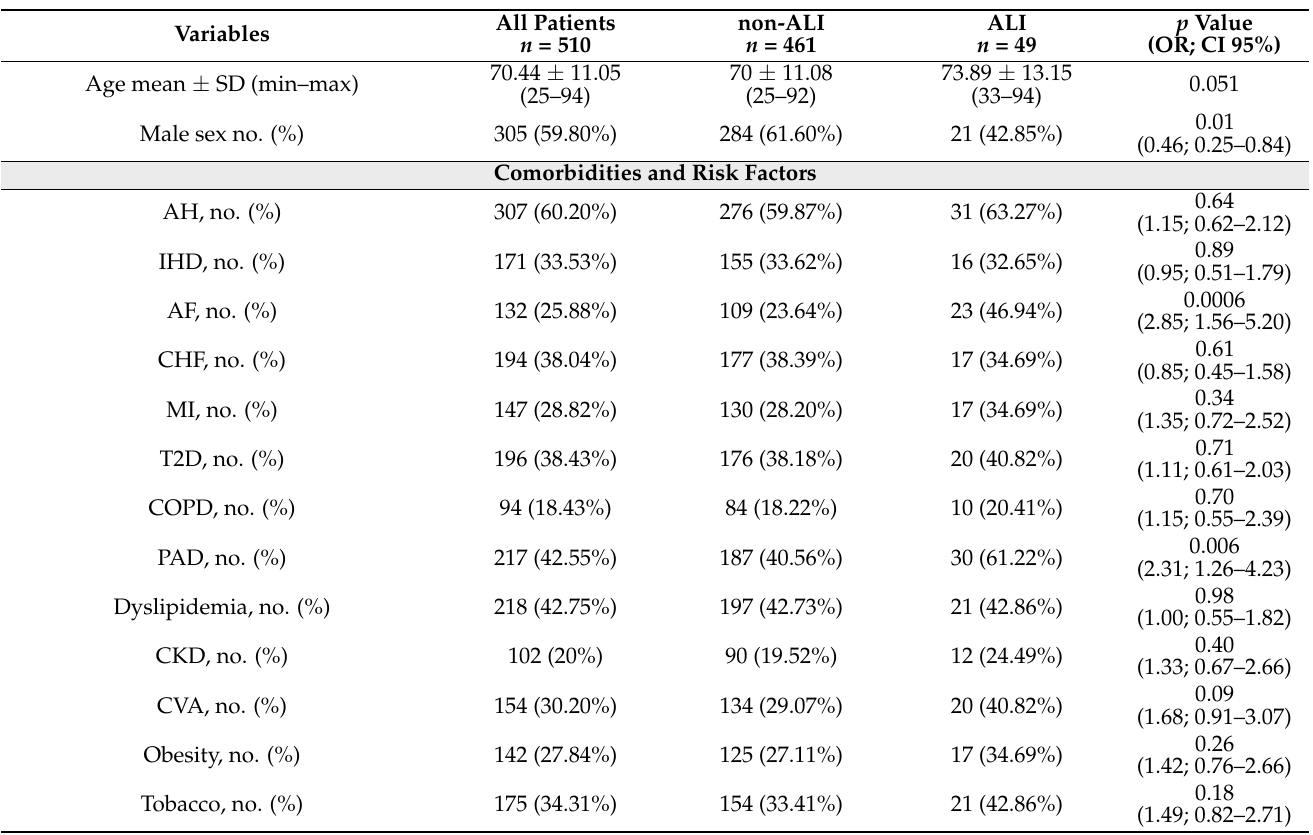
Table 1. Demographic data, comorbidities, risk factors, laboratory findings, and outcomes for all patients divided according to the ALI